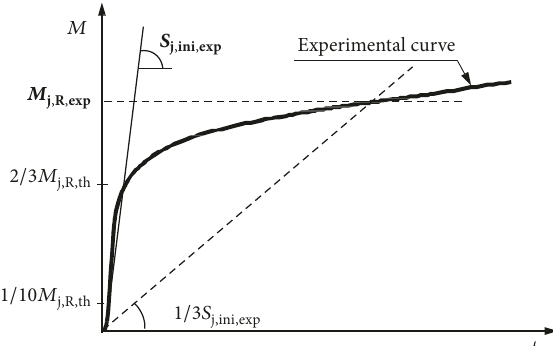
Figure 1: Experimental value of initial stiffness and plastic resis-